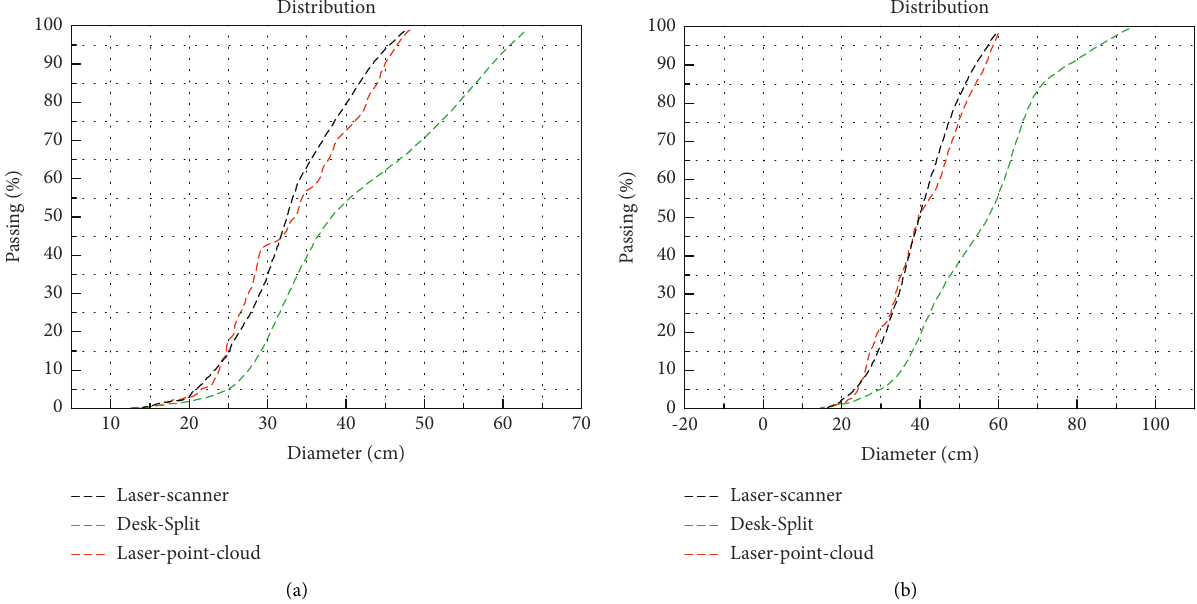
Figure 15: Size distribution of the stacked blocks using diameter compensation and interval of the surface rock blocks. (a) Test 1. (b) Test